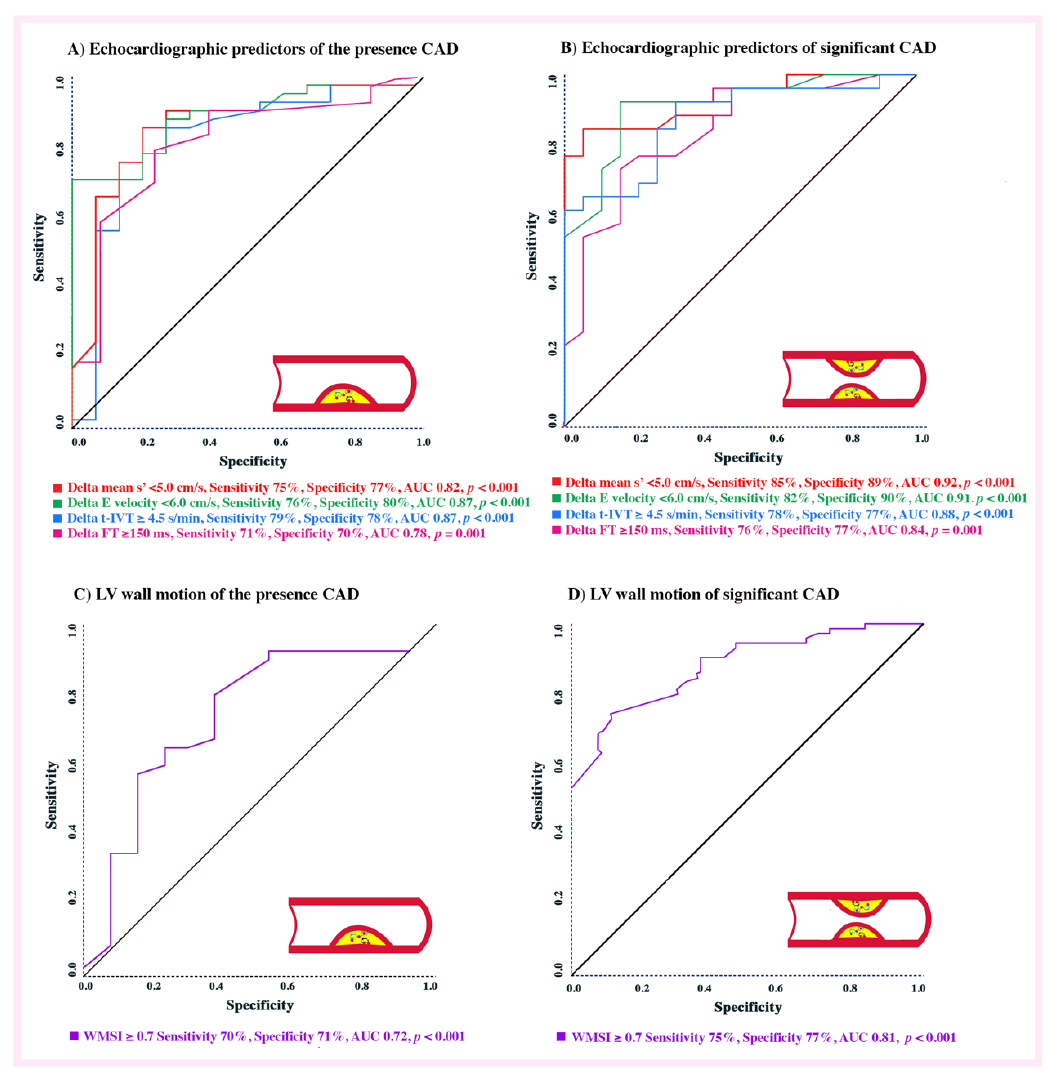
Figure 3. ROC analysis of echocardiographic predictors. ( A ) Echocardiographic predictors of the presence CAD. ( B ) Echocardiographic predictors of significant CAD. ( C ) LV wall motion score index of the presence CAD. ( D ) LV wall motion score index of significant CAD.